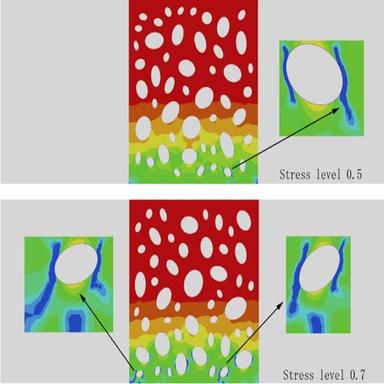
The simulated damage distribution in concrete near 90 % of the fatigue life under different stress levels .